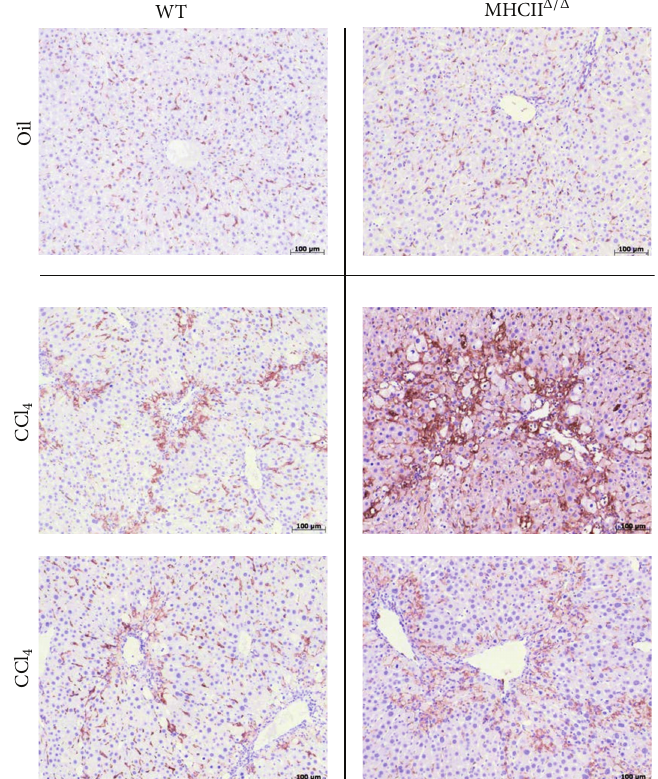
Figure 8: Effect of 4-week CCl 4 treatment on macrophage staining in wild-type and MHCII Δ/Δ mice. Macrophage staining (F4/80) showed a strong inflammation in both groups treated by CCl 4